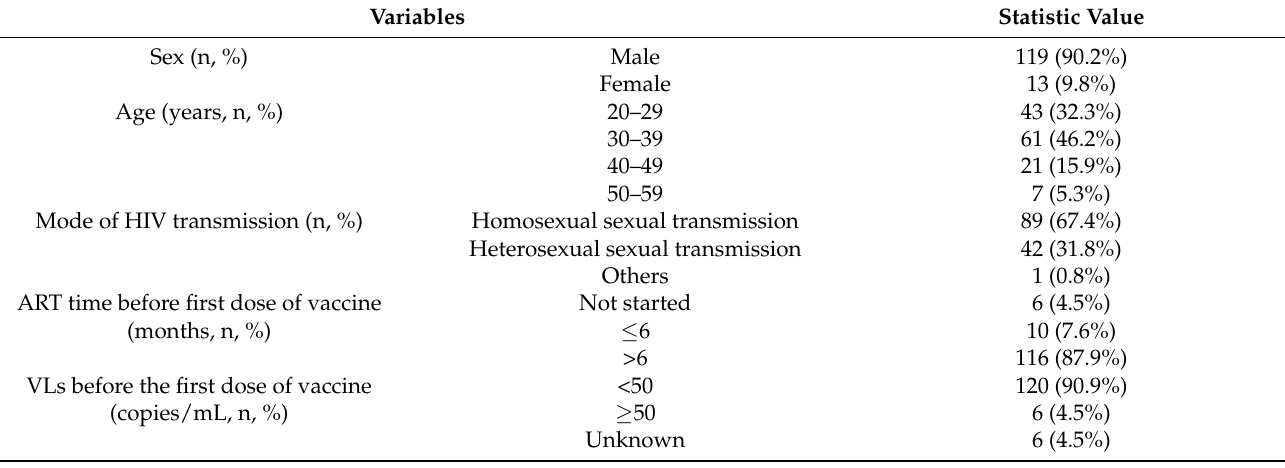
Table 1. Demographics, HIV characteristics, and types of vaccination of PLWH (N =